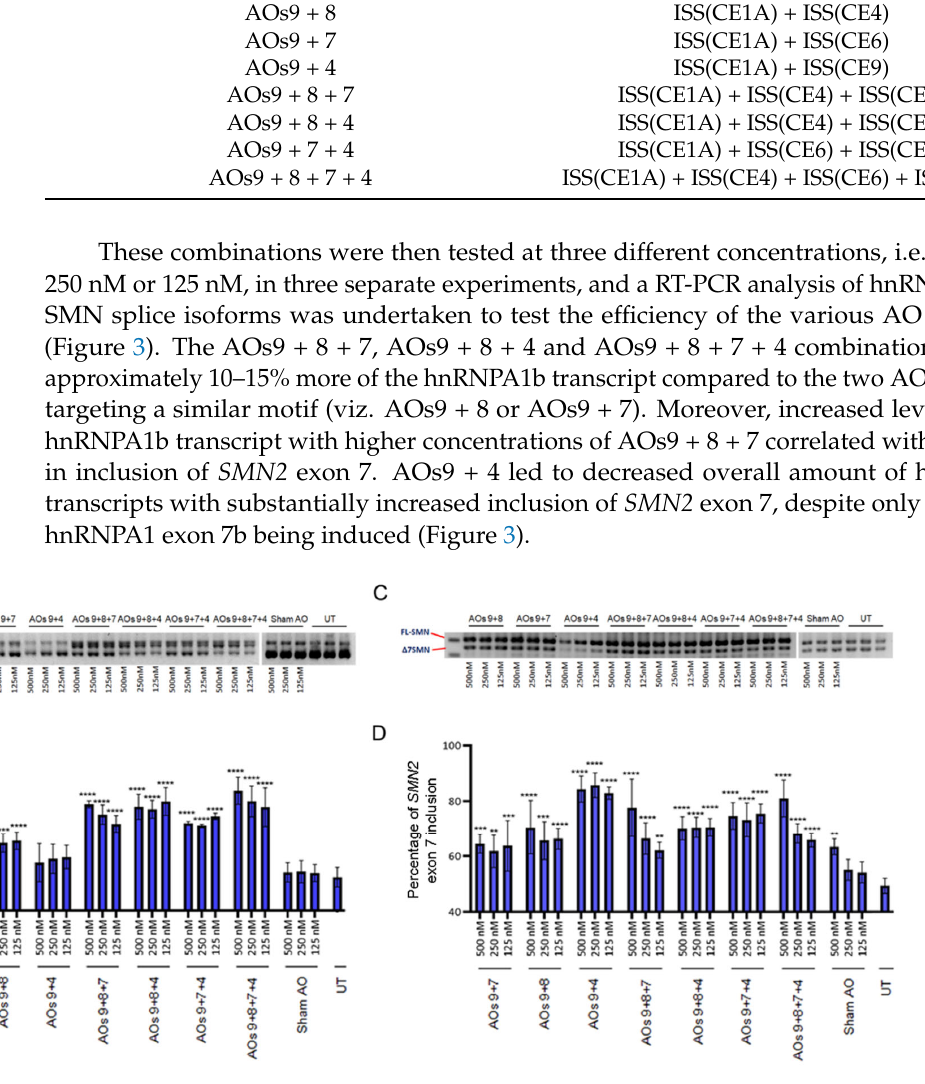
Figure 3. Gel images and densitometric analysis of RT - PCR of hnRNPA1 (( A ) and ( B )) and SMN (( C ) and ( D )) splicing isoforms in SMA fibroblasts transfected by seven combinations of AO cock ‐ tails, as well as densitometric analysis of the percentage of FL - SMN . The indicated concentrations were a dose of combined AOs in the cocktail. The * symbol indicates the p ‐ value of the average percentage of exon inclusion compared to untreated samples (viz ** = p < 0.01, *** = p < 0.001 and **** = p <